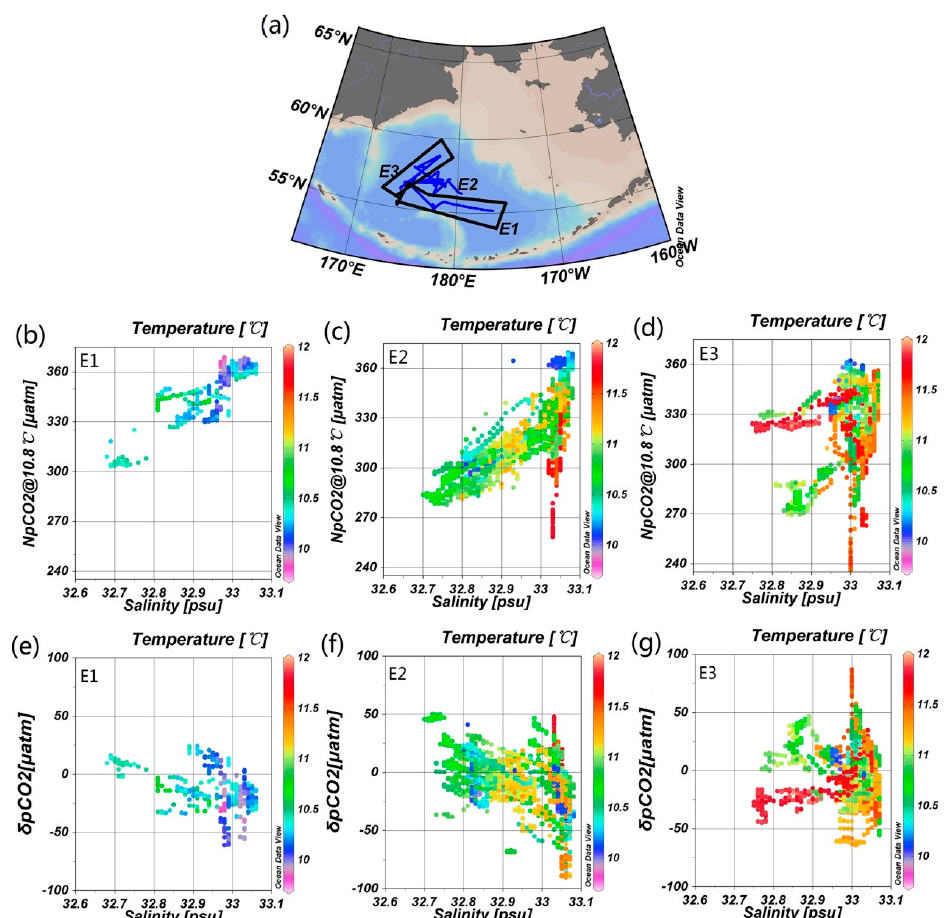
Figure 12. The relationship between p CO 2 , temperature, and salinity in the basin in August 2011. ( a ) Cruise tracks with data divided into three groups marked by E1, E2, and E3 ( b – d ) are the relationship between p CO 2 normalized to the average temperature 10.8 °C (N p CO 2 ) and salinity in E1, E2, and E3, respectively; ( e – g ) are the relationships between δ p CO 2 (the difference between satellite-derived p CO 2 and in situ p CO 2 ) and the underway salinity data.